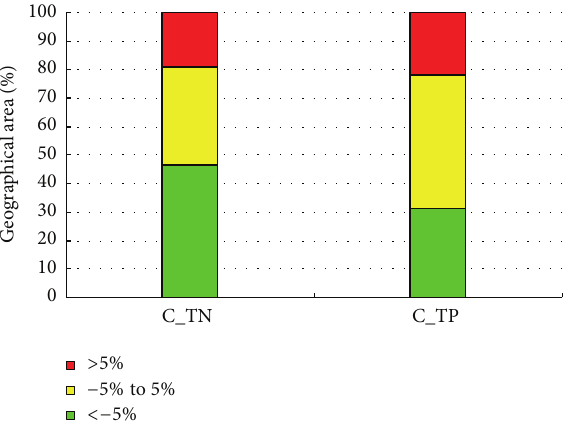
Figure 7: Percentage of geographical area under positive high, modest, or negative high classes.